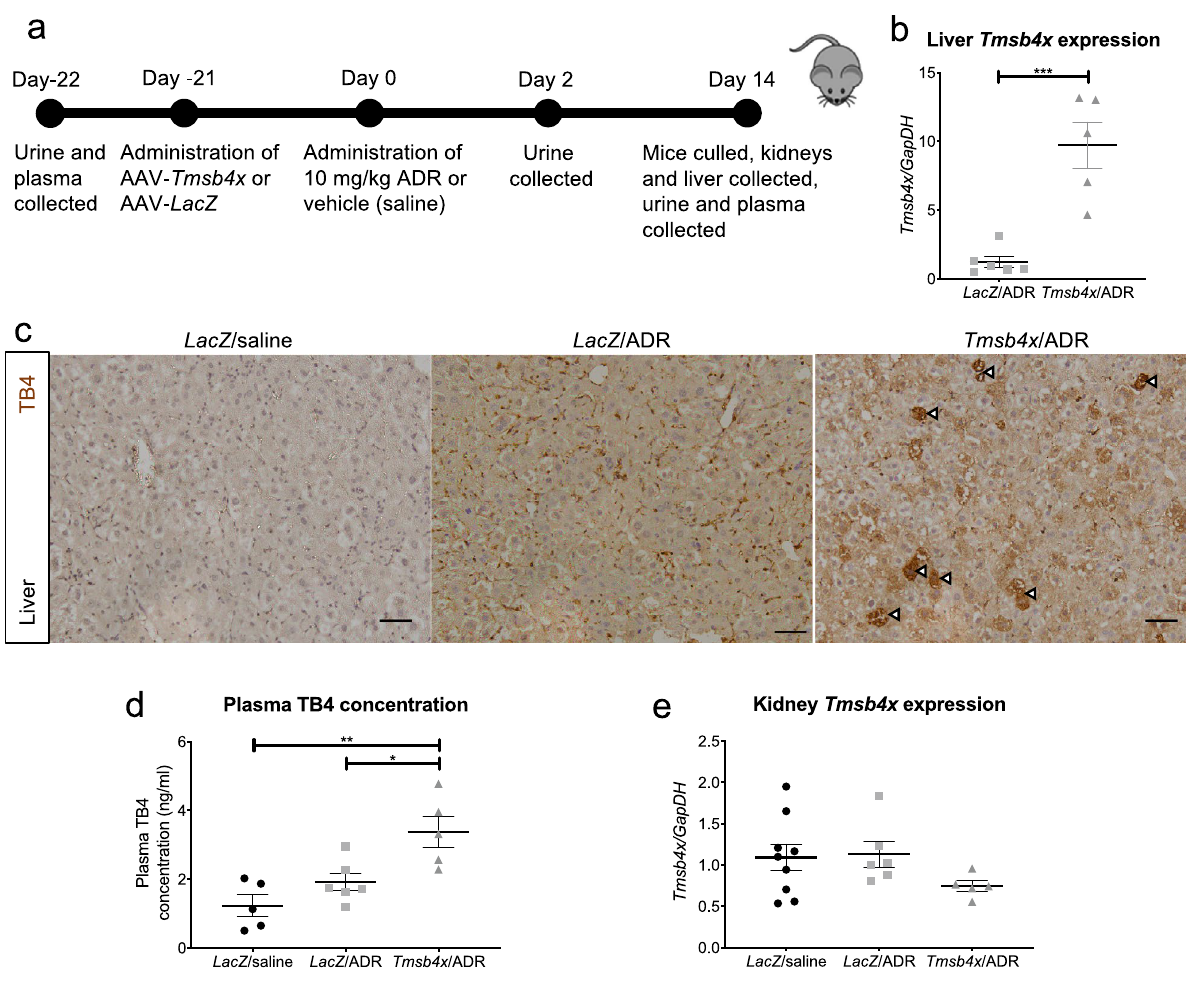
Figure 2. AAV2/7 causes systemic upregulation of thymosin β4 in vivo. ( a ) BALB/c mice were injected with AAV- LacZ or AAV- Tmsb4x three weeks prior to 10 mg/kg ADR or vehicle (saline) administration and culled 14 days after ADR/saline injection at which point thymosin β4 levels were quantified. ( b ) Liver expression of Tmsb4x mRNA (unpaired t test) . ( c ) Expression of TB4 peptide in the liver. Arrowheads refer to cells with particularly high expression of TB4. Scale bars = 50 µm. ( d ) Plasma concentration of TB4 (one-way ANOVA with Tukey post hoc test). ( e ) Whole kidney expression of Tmsb4x gene (one-way ANOVA with Tukey post hoc test). LacZ /saline, n = 9; LacZ /ADR, n = 6; Tmsb4x /ADR, n = 5. Data are presented as the mean ± SEM; * P ≤ 0.05, ** P ≤ 0.01 and *** P ≤ 0.001. TB4, Tmsb4x, thymosin β4; ADR, Adriamycin; LacZ , β-Galactosidase; AAV, adeno- associated